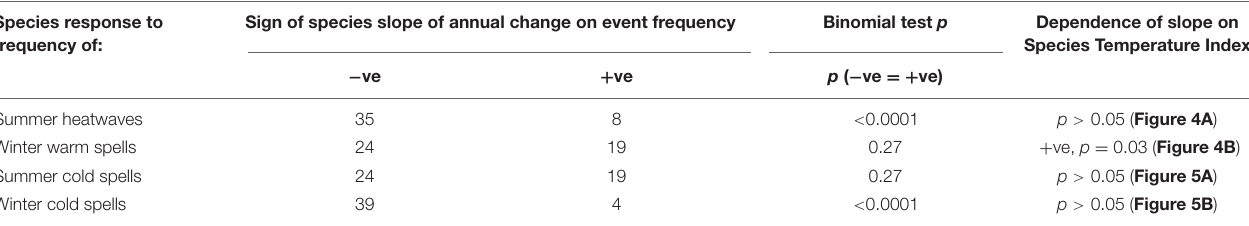
TABLE 2 | Meta-analysis of species responses to frequencies of extreme climatic events, expressed as the sign of the slope of annual change in abundance to the number of extreme events, for time series in abundance of United Kingdom rocky shore species between 2002 and 2019. Species response to Sign of species slope of annual change on event frequency of: